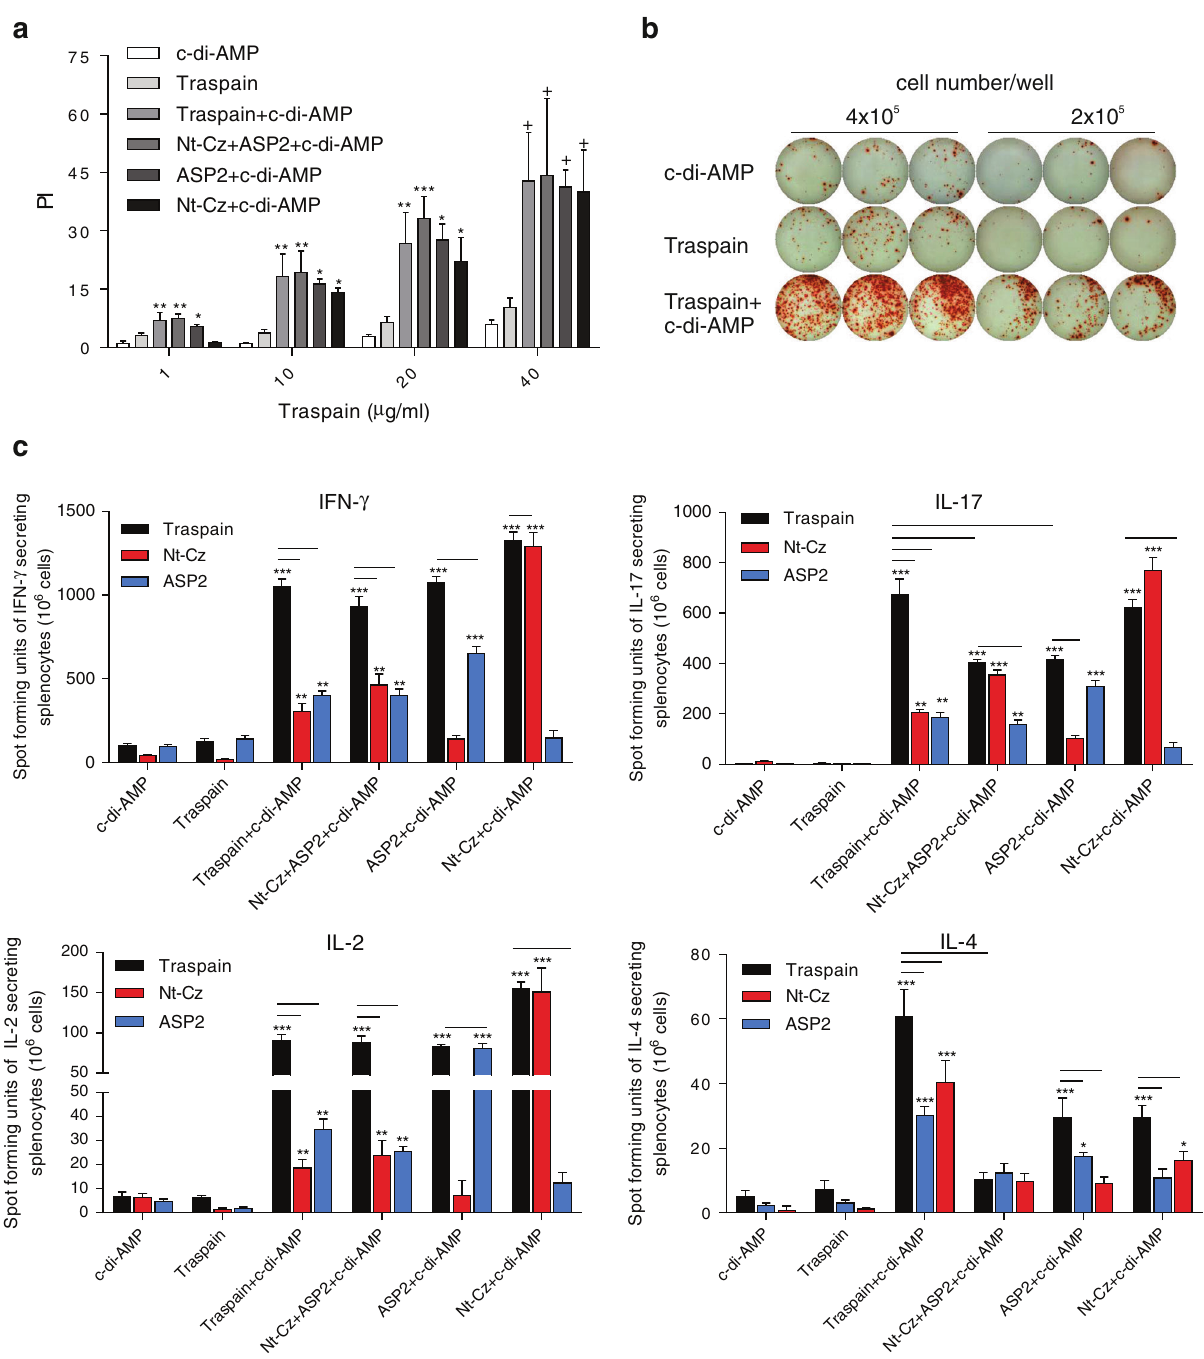
Fig. 2 Cellular immune response in vaccinated mice. Proliferative dose-response curve of spleen cells harvested 30 dpi from vaccinated mice upon increasing concentrations of Traspain. Proliferation index (PI) ( a ). Secreted cytokines by ELISPOT assay at 30 dpi. Representative ELISPOT plate showing IFN- γ producing colonies of spleen cells from indicated groups cultivated in the presence of 10 µg/ml of Traspain ( b ). Pooled- splenocytes were re-stimulated with the indicated protein and mean number of spot forming units were determined for IFN- γ , IL-17, IL-2, or IL-4 ( c ). Results are expressed as mean ± SEM, n = 18 from 6 mice per group. One-way-ANOVA+Dunnett multiple comparison test. * p < 0.05, ** p < 0.01, *** p < 0.001 comparing with c-di-AMP group. Bars indicate signi fi cant difference ( p < 0.05) between the indicated category of stimulus and groups, two-way-ANOVA + Tukey ’ s multiple comparisons test. All results are representative of two independent experiments protection levels were observed in Traspain, ASP2 or Nt-Cz+c-di- AMP groups in terms of survival rate (Fig. 6c). However, Nt-Cz +ASP2+c-di-AMP group failed to achieve equal protection. As a whole, animals immunized with strategies different from Traspain +c-di-AMP presented an intermediate performance. npj Vaccines (2017)